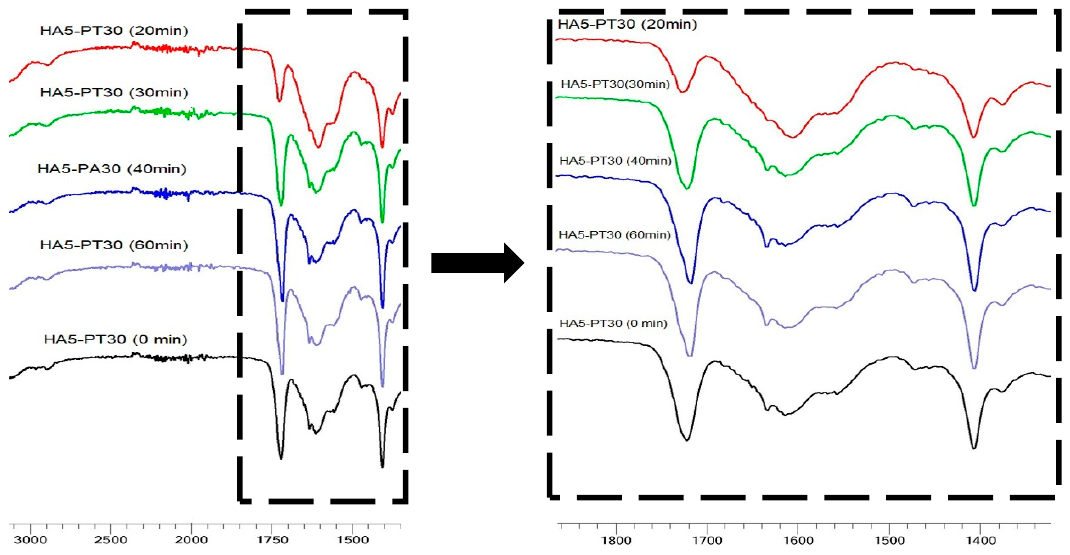
13 of 20 Figure 7. HA5-PT20 crosslinked by UV irradiation (x-axis is the wavenumber/cm -1 ). The FTIR data for the microwave cross-linked HA5-PT samples was in congruence with their swelling data. HA5-PT30 exhibited poor cross-linking due to excess PT (Figure 8). HA5-PT20 was the